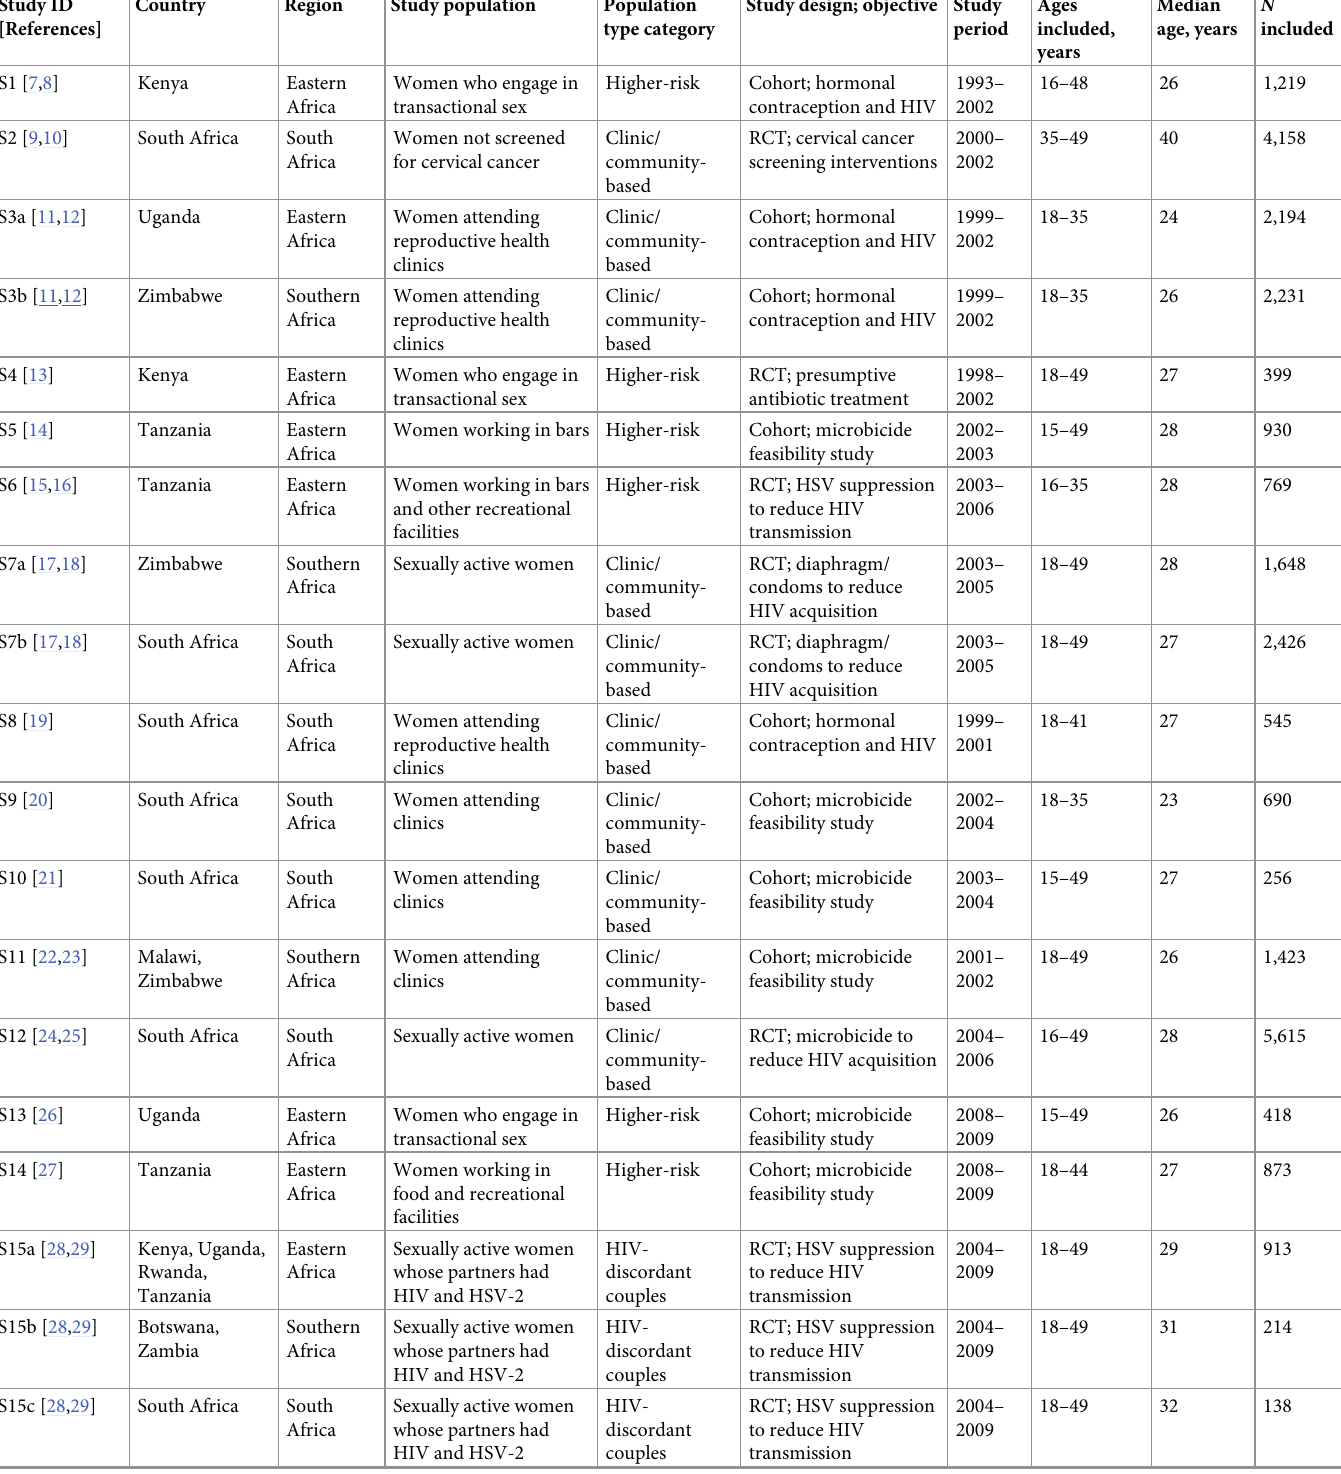
Table 1. Summary characteristics of included